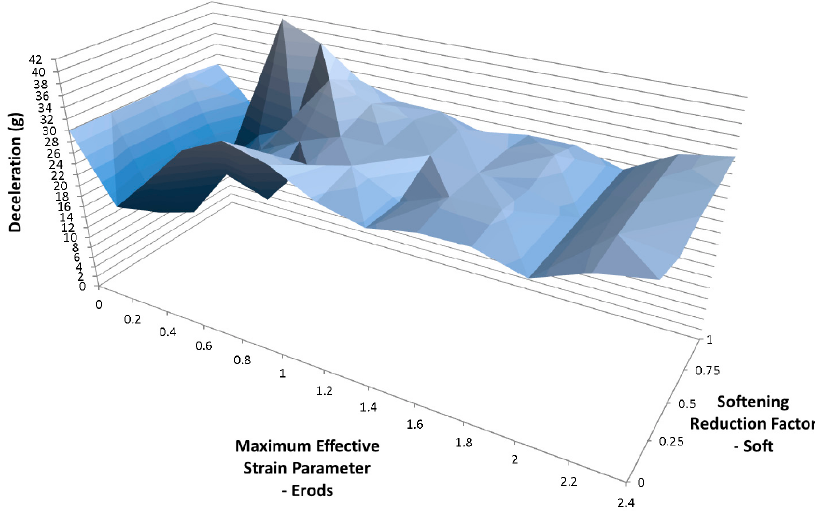
Figure 14. Effect of Erods parameter and Soft factor with All Slim = 1.0, Size = 1 × 10 − 11 and FS = − 1.0.